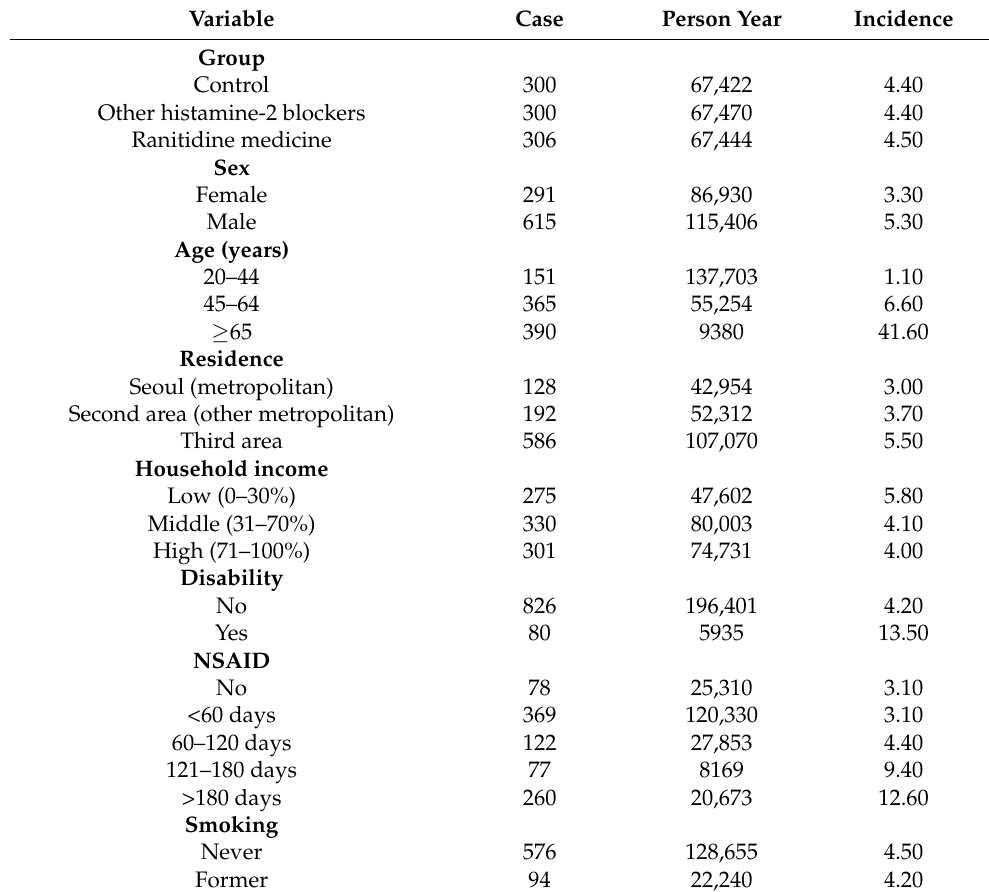
Table 2. Incidence of gastric cancer according to different